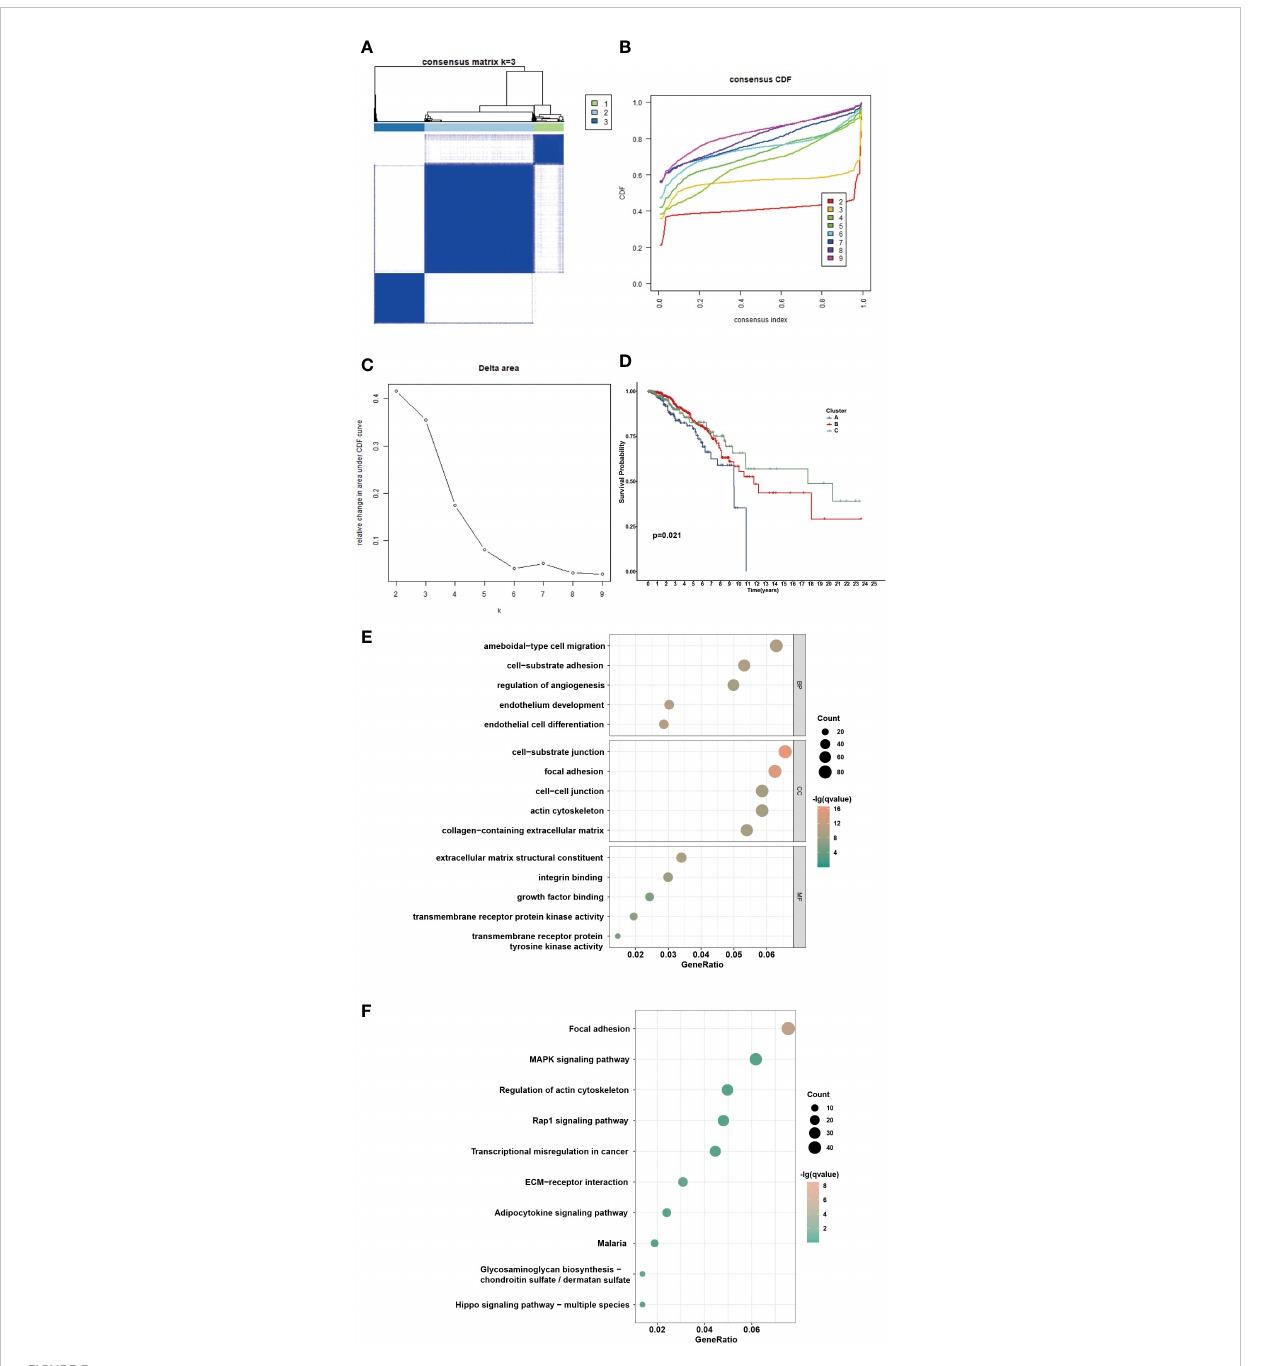
FIGURE 3 Identi fi cation of potential NAM metabolism-related clusters in BC patients. (A) The consensus clustering analysis of NMRGs in TCGA-BRCA cohort (k=3). (B) Consensus CDF. (C) Delta area. (D) The OS Kaplan-Meier curve of different clusters. (E-F) GO and KEGG enrichment analysis of differential expressed